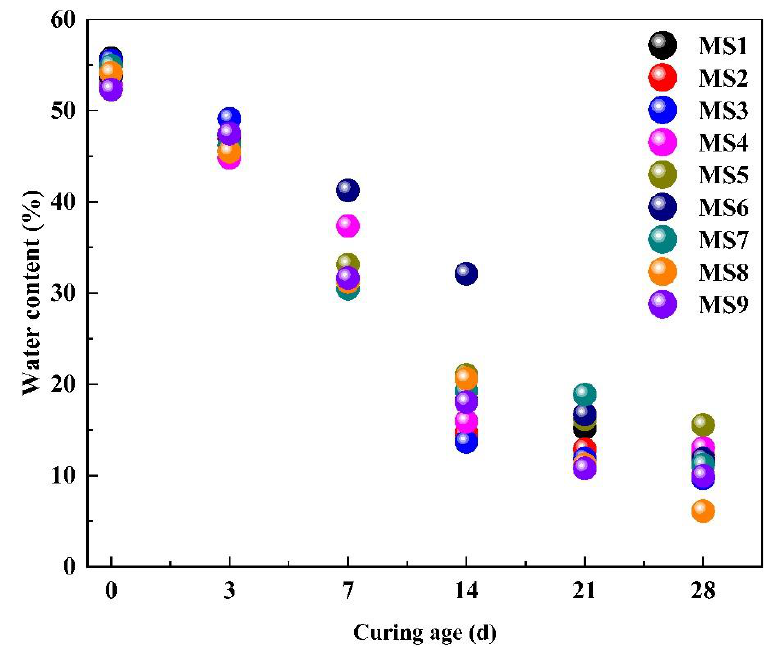
Figure 3. Water content of solidified sludge samples.